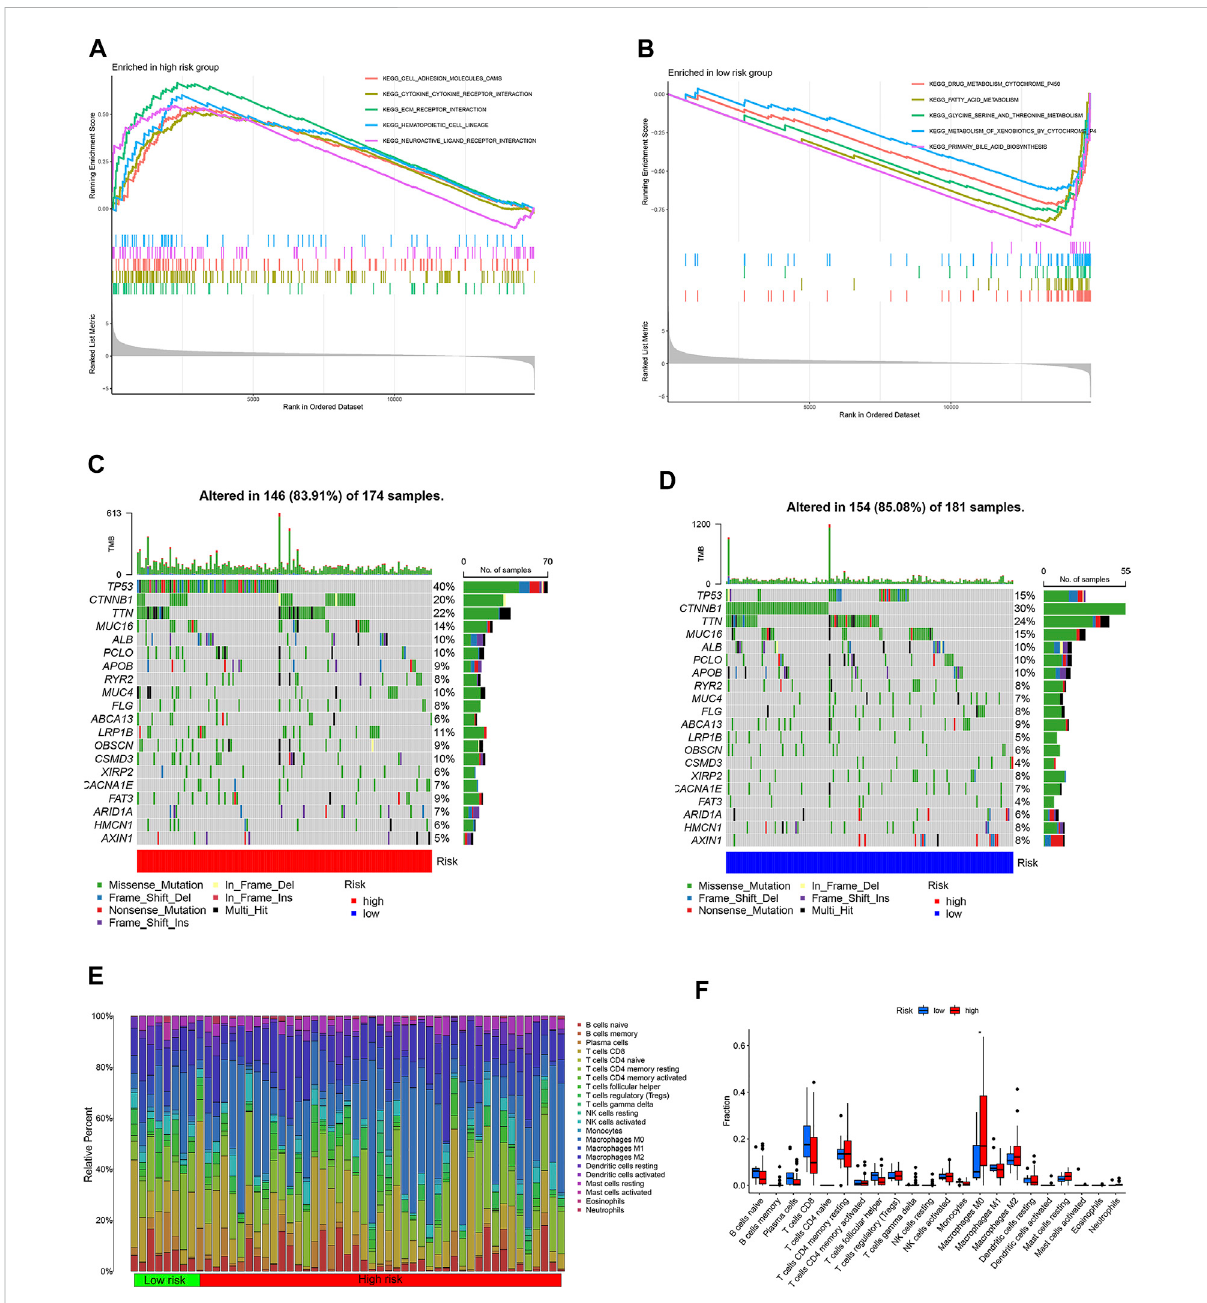
FIGURE 4 GSEA enrichment, tumor mutation burden and immune cell in fi ltration analyses. (A) GSEA enrichment analysis of high-risk subgroup. (B) GSEA enrichment analysis of low-risk subgroup. (C) tumor mutation burden waterfall plot of high-risk subgroup. (D) tumor mutation burden waterfall plot of low-risk subgroup. (E) heatmap of 22 type immune cells relative in fi ltration content. (F) difference analysis of 22 type immune cells relative in fi ltration content between high- and low-risk